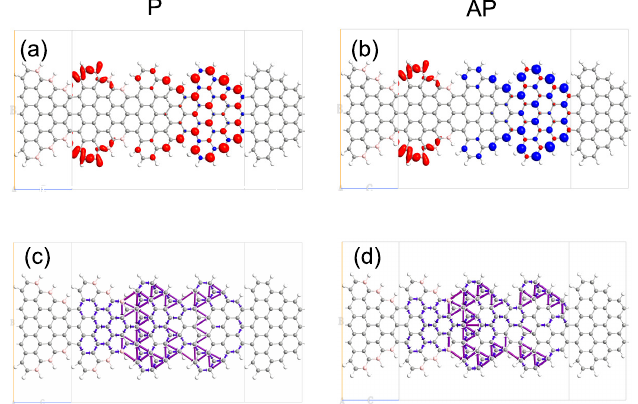
Figure 5. (Color online) ( a , b ) Isosurface plots of the spin density ( ∇ ρ = ρ α − ρ β ) for M1 in P/AP configuration, where values for red ( α -spin) and blue ( β -spin) isosurfaces are ± 0.002 | e | /Å 3 , respec- tively. ( c , d ) The transmission pathway of the central scattering region for M1 in P/AP configuration,